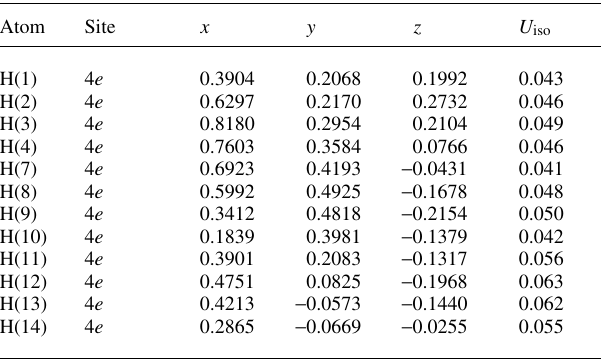
Table 2. Atomic coordinates and displacement parameters (in Å 2 )